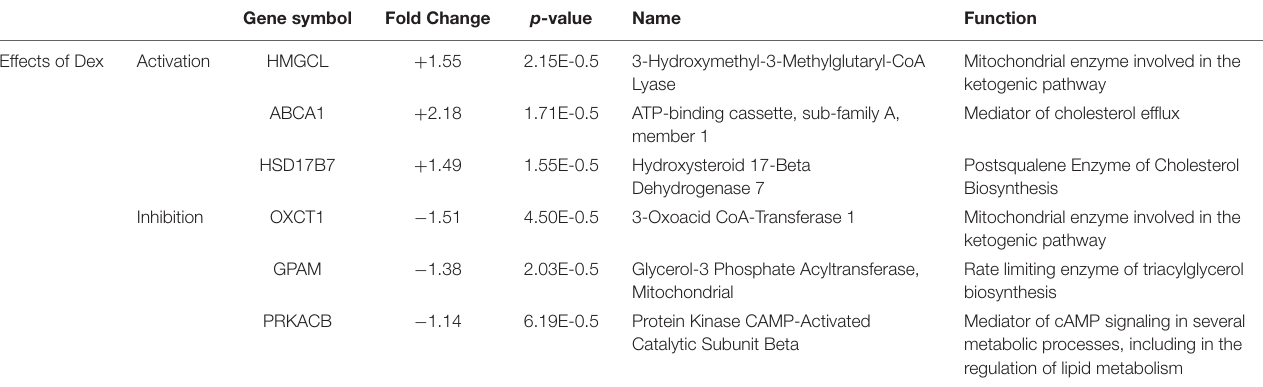
Gene symbol Fold Change p